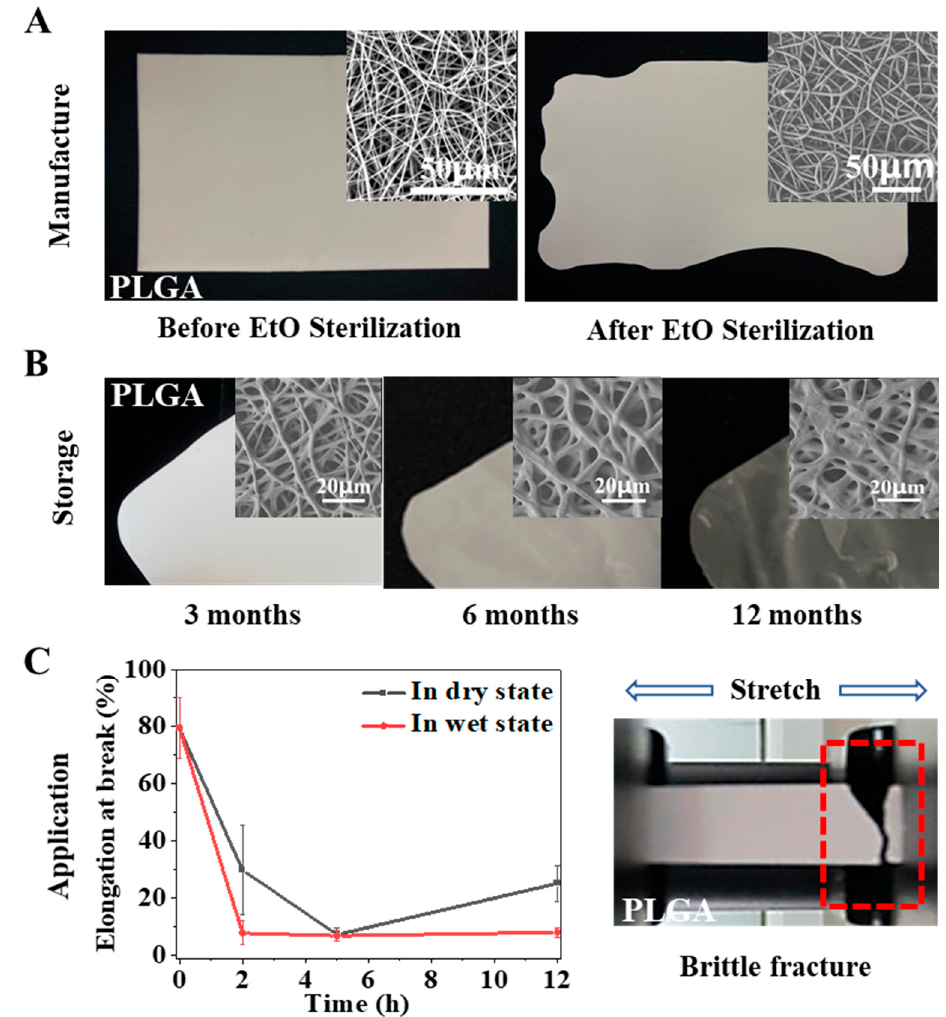
Figure 1. Stability obstacles of PLGA membrane. Morphology and performance changes of pure PLGA electrospun membrane during manufacture ( A ); storage ( B ); application ( C ).